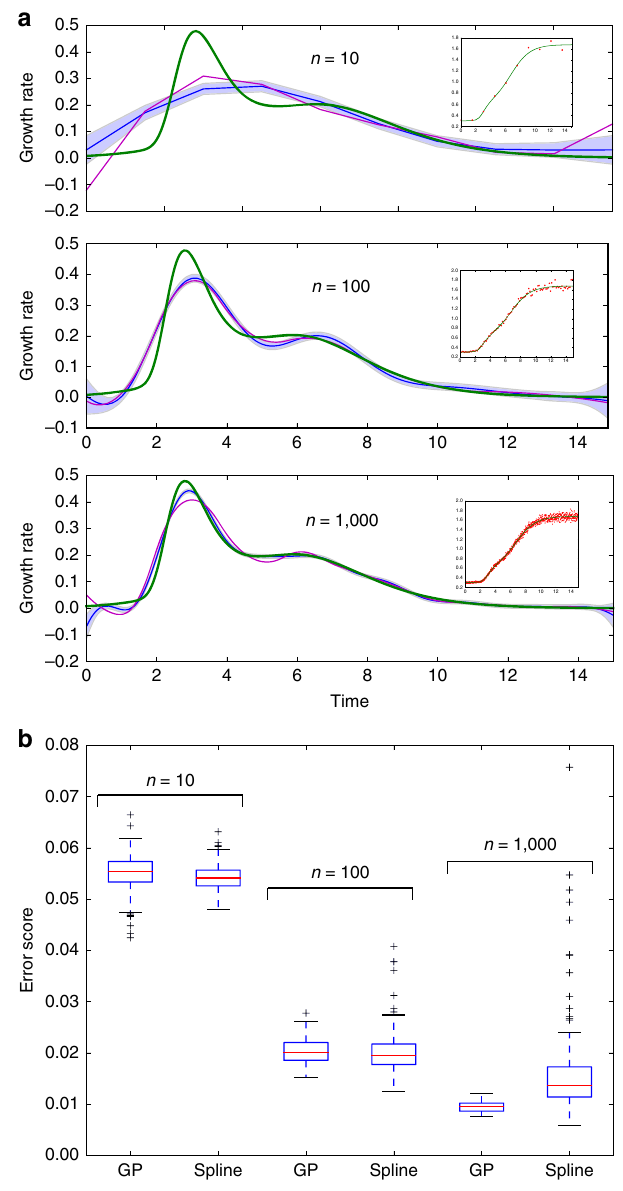
Figure 3 | Inference of growth rates with Gaussian processes becomes more robust with increasing numbers of data points. ( a ) We show the inferred growth rate (the best fit with a squared exponential Gaussian process in blue with errors in light blue and from a cubic smoothing spline in purple) and the exact growth rate (in green) for synthetic data sets with either 10, 100 or 1,000 time points (insets, with the underlying growth curve in green). Even though we favour smoothing splines by setting the smoothing parameter to be proportional to the exact variance of the measurement noise (whereas the Gaussian process infers this parameter), both methods perform similarly. ( b ) A box plot of errors scores for inference of the growth rate from 100 data sets with randomly generated log-normal measurement noise. For the Gaussian process, the distribution of error scores tightens with increasing number of data